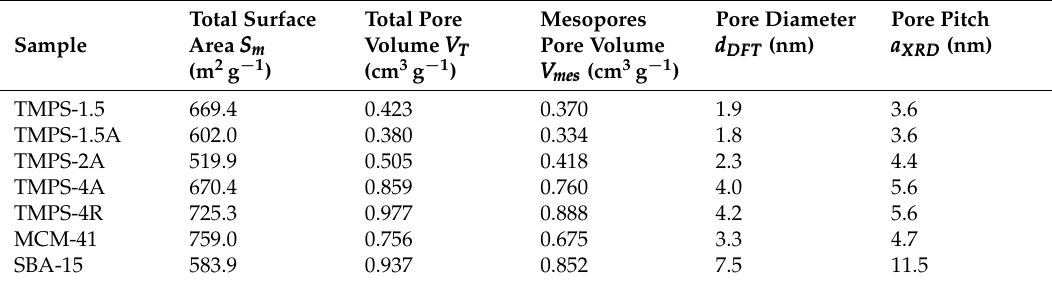
Table 1. Materials properties; total surface area S m (BET), total pore volume V T , mesopores pore volume V mes , pore diameter d DFT and pore pitch a XRD